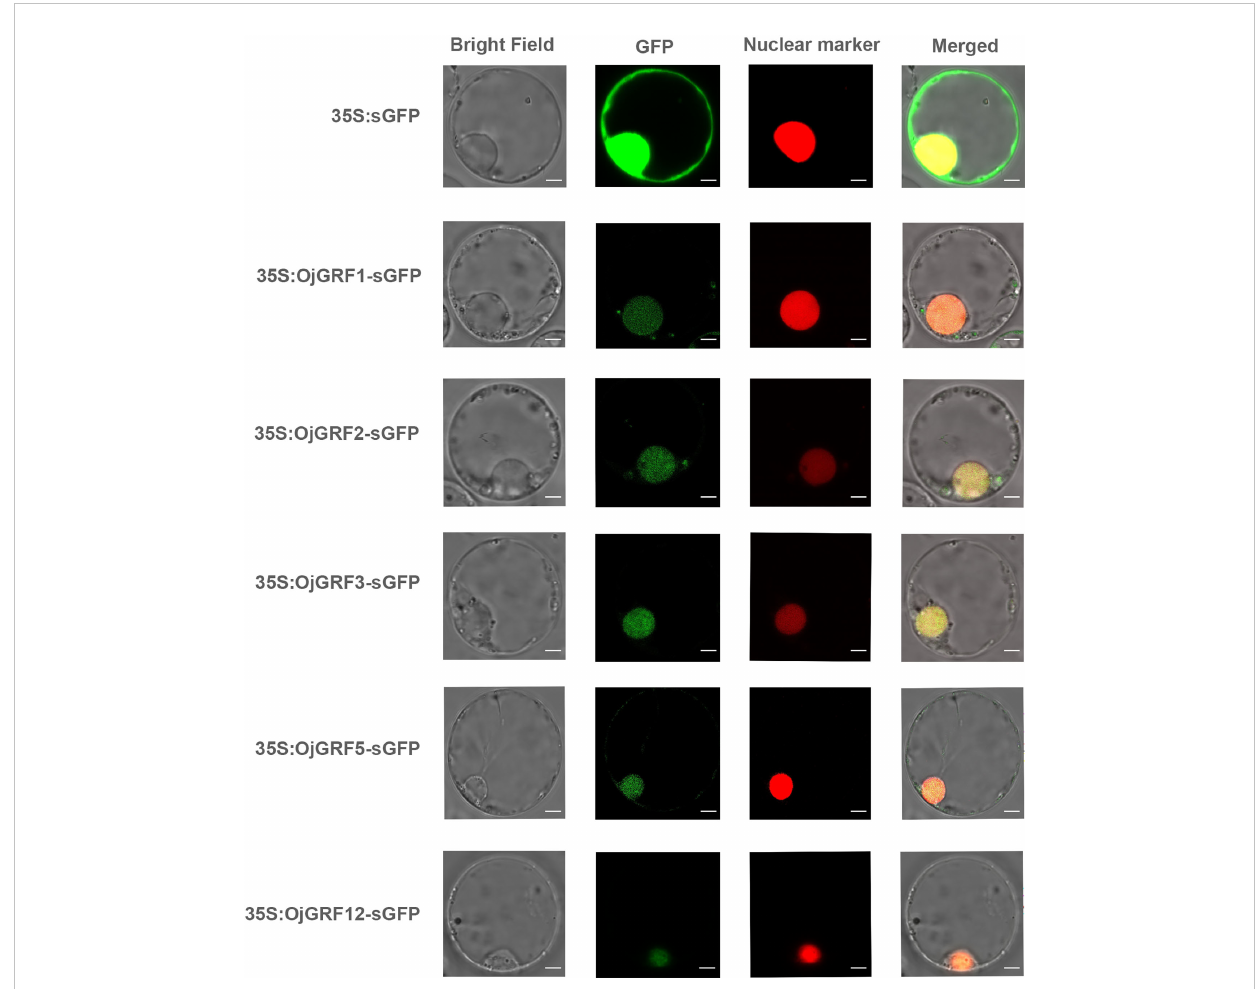
FIGURE 6 The subcellular localization of GRFs protein in rice protoplasts. The GRFs were fused to the GFP signal protein and the RFP signal represents the nucleus. The empty vector, HBT-sGFP, was used as a control. Scale bars correspond to 5